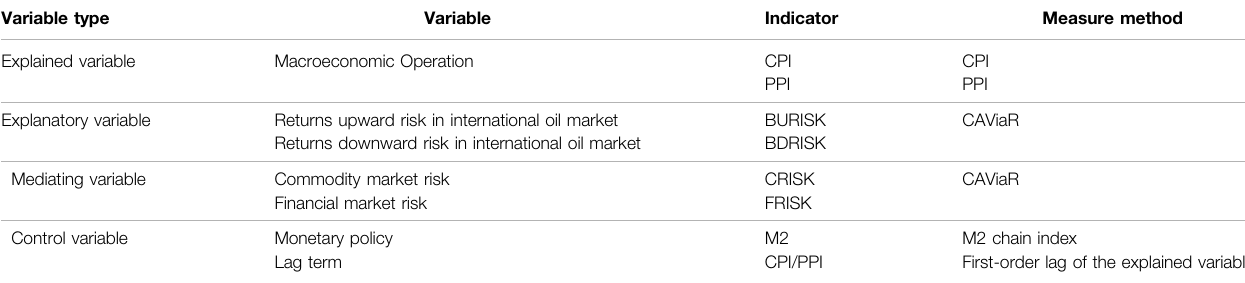
TABLE 1 | Selection of mediating effect test variables.